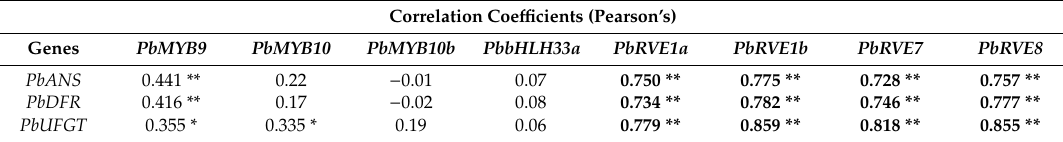
Table 1. Correlation analysis between the expression of anthocyanin-related transcription factors (TFs) and the expression of ALBG s in pear